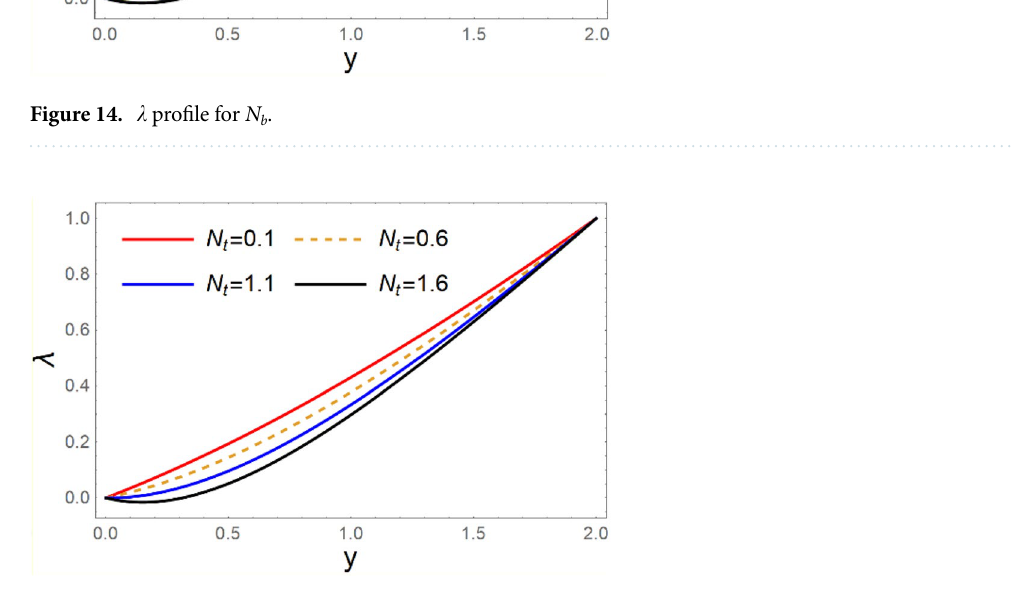
Figure 15. λ profile for N t